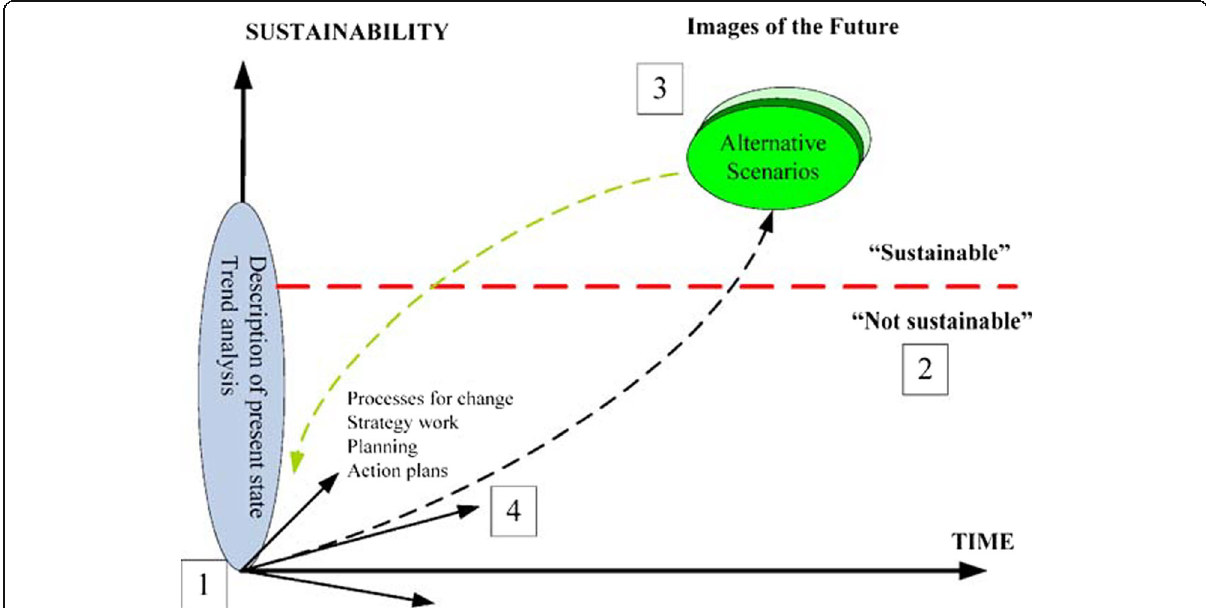
Fig. 2 The city foresight methodology use in the Project Gothenburg 2050. Source: Phdungsilp [51]. Illustrates the overall picture of the planning methodology used in the Project Gothenburg 2050, which consists of four steps, namely 1 description of the present and trend analysis, 2 setting criteria and goals (sustainability), 3 developing images of the future, and 4 analysis of how to reach the